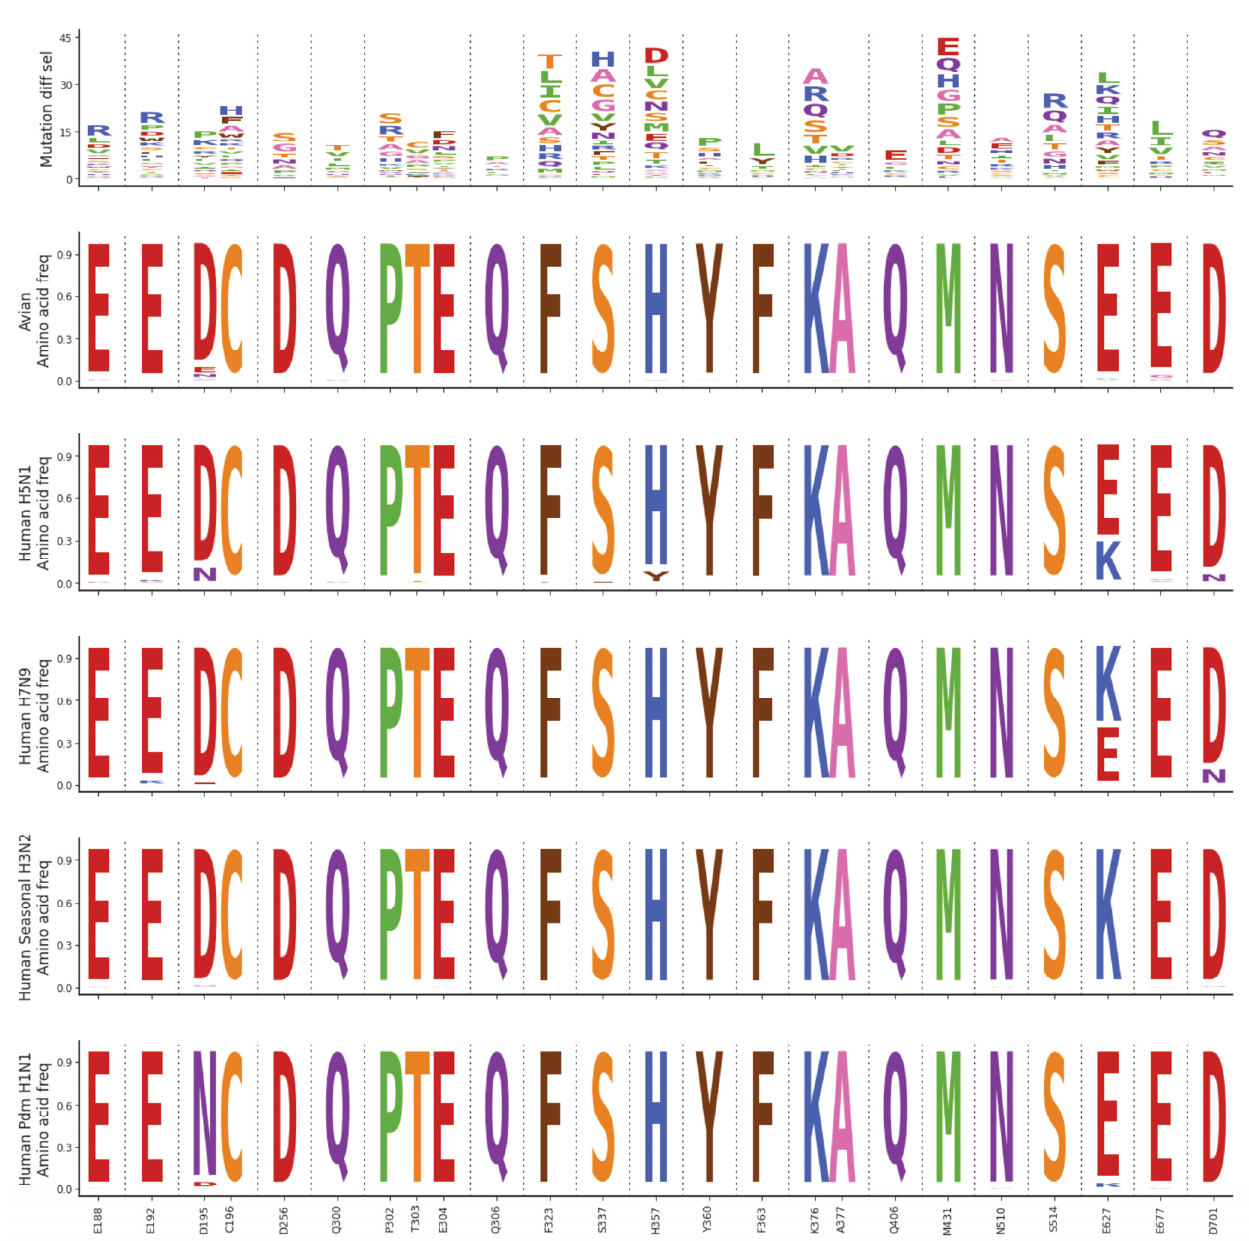
Figure 4. Natural sequence variation at sites of pimodivir resistance. Logoplots representing mutation differential selection under pimodivir selection (top row) and amino acid frequencies in various influenza strains (remaining rows). For the plot representing the mutation differential selection, the height of each amino acid is proportional to its differential selection. For the plots representing the amino acid frequency, the height of each amino acid is proportional to its frequency observed in the specified influenza strains.